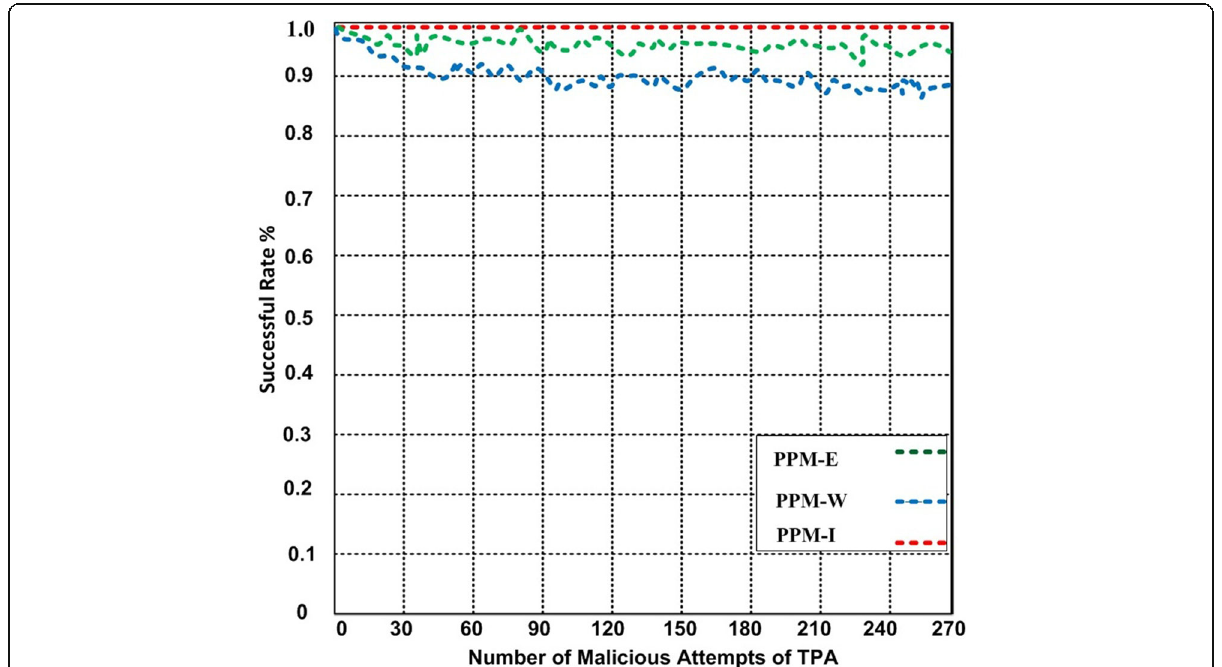
Fig. 11 Number of malicious attempts of TPA versus successful rate of detecting the malicious behavior